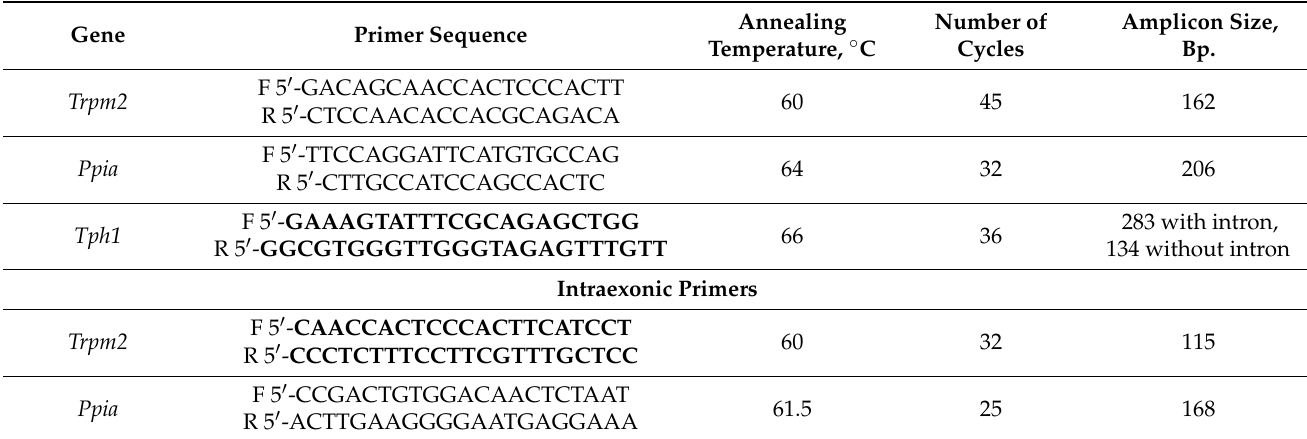
Table 1. Characteristics of primers used to quantify mRNA of thermosensitive TRPM2 ion channel in rat